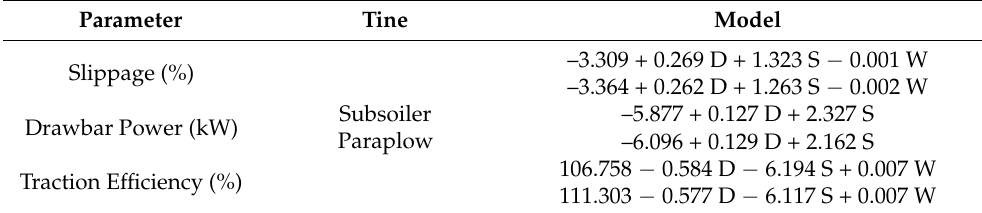
Table 3. Regression prediction models for studied parameters of tines.